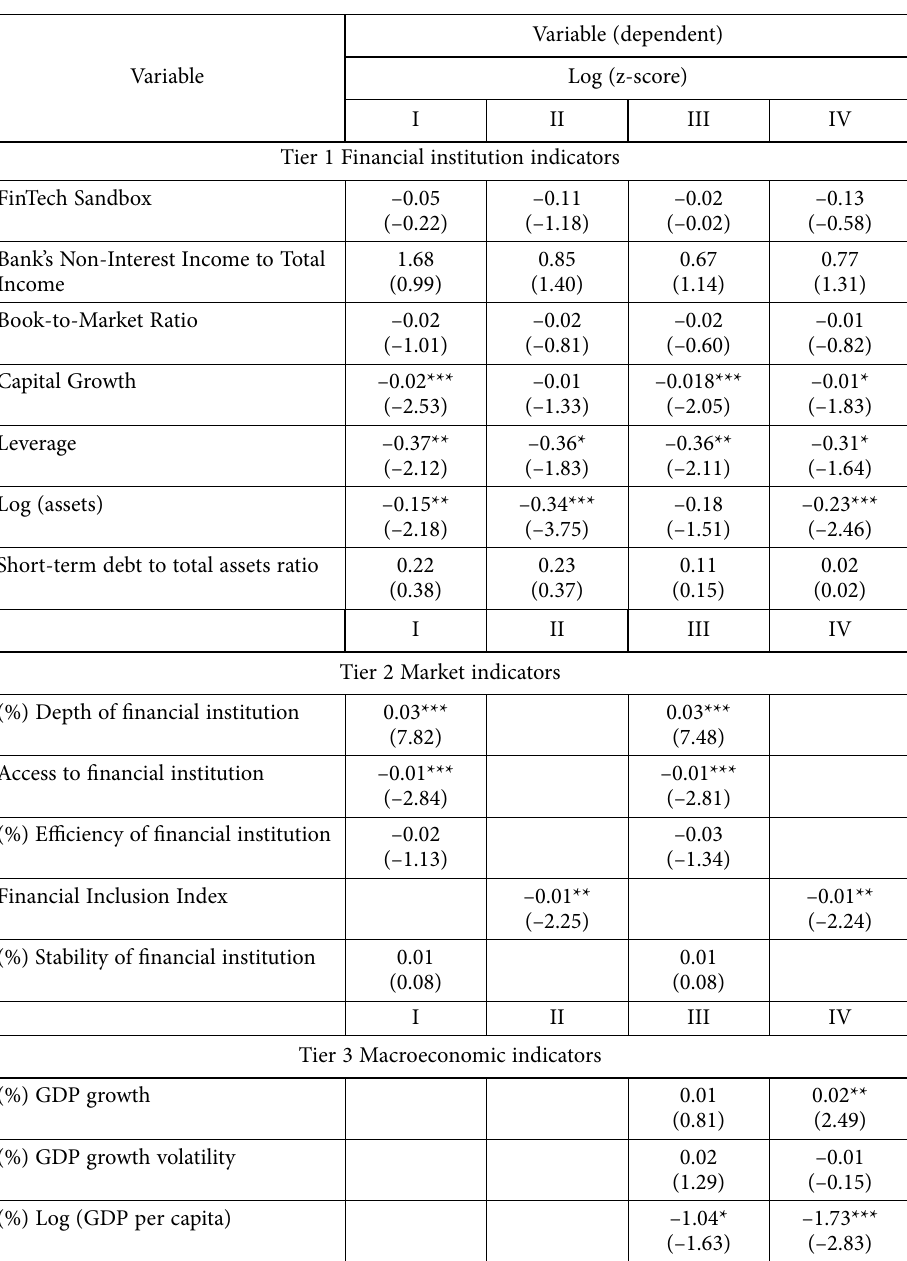
Table 2. Introduction of FinTech sandboxes (regression of